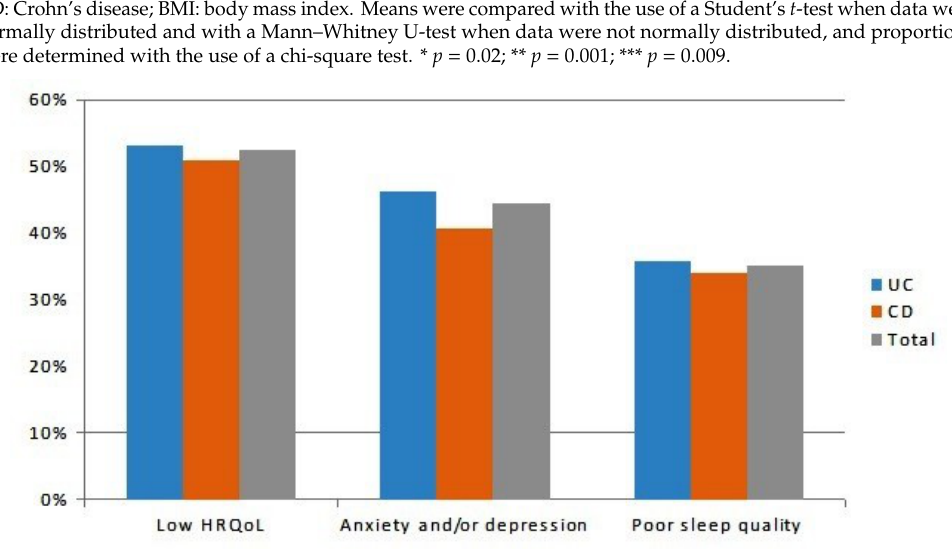
Figure 1. Percentages of the 202 inactive inflammatory bowel disease (IBD) patients ( n = 143 UC and n = 59 CD) with a low health-related quality of life (HRQoL), anxiety and/or depression status, and poor sleep quality. UC: ulcerative colitis; CD: Crohn´s disease.